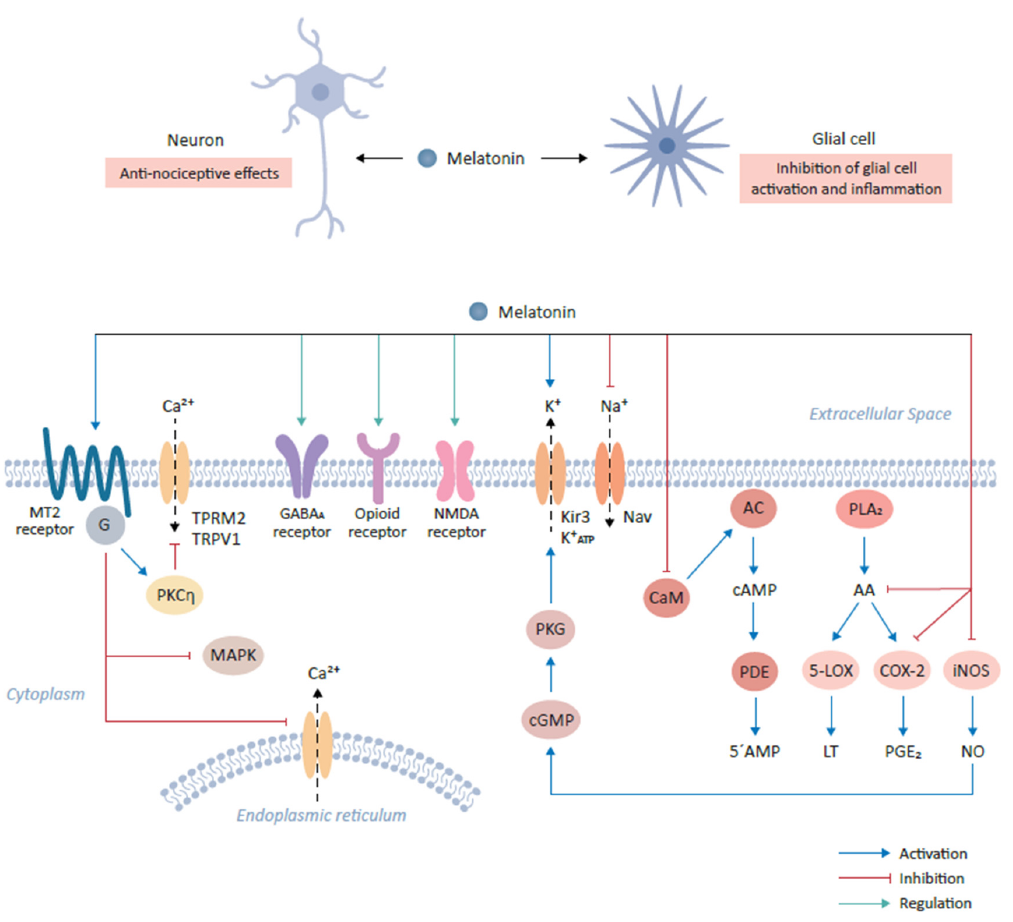
Figure 1. Role of melatonin and its cognate receptors in pain-relieving signal pathways. The binding of melatonin to MT2 receptors expressed on glutamatergic neurons mediates anti-nociceptive effects. This interaction results in the activation of the PKC η signaling pathway and in turn suppresses mitogen-activated protein kinase (MAPK) and calcium signaling. The interaction of melatonin with various neurotransmitter receptors, including gamma-aminobutyric acid (GABA)ergic (GABA A ), produces anti-nociceptive effects. Furthermore, melatonin binds opioid and NMDA receptors to mediate downstream signaling, resulting in anti-nociceptive effects. Additionally, melatonin modulates ion flow by binding to Kir3 K + channel which activates the outflow of K + ions in the central nervous system. Conversely, melatonin inhibits the activities of sodium channels, including NAV1.8 and NAV1.9. Melatonin prevents the influx of Ca 2+ by inhibiting calmodulin (CaM). CaM modulates intracellular 5’-AMP levels through the step-wise activation of adenylyl cyclase (AC) and cyclic nucleotide phosphodiesterase (PDE) by the intermediate generation of cAMP. Finally, melatonin modulates